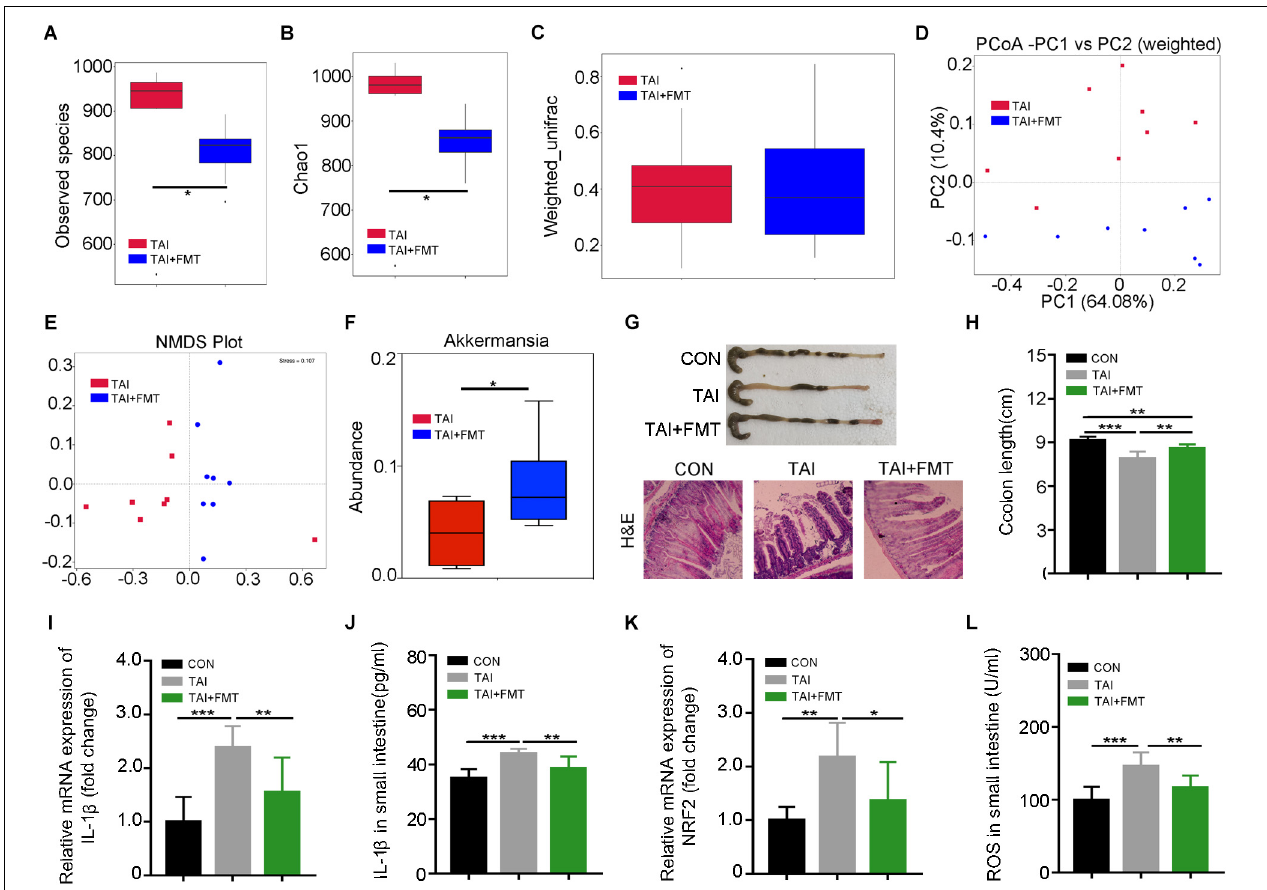
FIGURE 3 | Walking mitigates intestinal radiation toxicity depending on gut microbiota. Male mice were exposed to 12 Gy of TAI, and for TAI + FMT group, irradiated mice were administrated with fecal microbiota via oral route from male donors that maintained walking following radiation exposure. The gut bacterial composition structures in male mice of TAI and TAI + FMT groups were measured by 16S rRNA high-throughput sequencing at 16 days after TAI exposure, n = 8 per group. The colon and small intestine tissues were obtained at day 16, n = 10 per group. (A,B) Alpha diversity was measured: (A) the observed species number and (B) Chao1 diversity index. (C) The beta diversity of intestinal bacteria. (D,E) PCoA (weighted) and NMDS were performed to assess the alteration of gut bacteria taxonomic profile from male mice in two groups. (F) The abundance of Akkermansia in male mice of two groups. (G) Photographs of dissected colon and morphology of the small intestine shown by H&E from male mice in the two groups. (H) Statistical results of colon length between two groups. (I,K) The expression levels of IL-1 β and NRF2 were examined in small intestine tissues from male mice by qRT-PCR. (J,L) The levels of IL-1 β and ROS in the small intestine of male mice were measured by ELISA. (A–C) Significant differences are indicated: Wilcoxon rank sum test. (D–L) Significant differences are indicated: * p < 0.05, ** p < 0.01, and *** p < 0.005 by Student’s t -test between two cohorts. TAI, total abdominal irradiation; FMT, fecal microbiota transplantation; PCoA, principal coordinates analysis; NMDS, non-metric multidimensional scaling; ROS, reactive oxygen